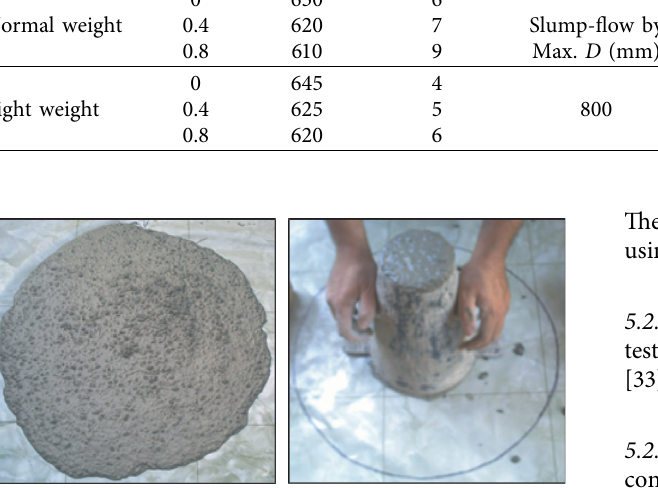
Figure 4: Slump-flow